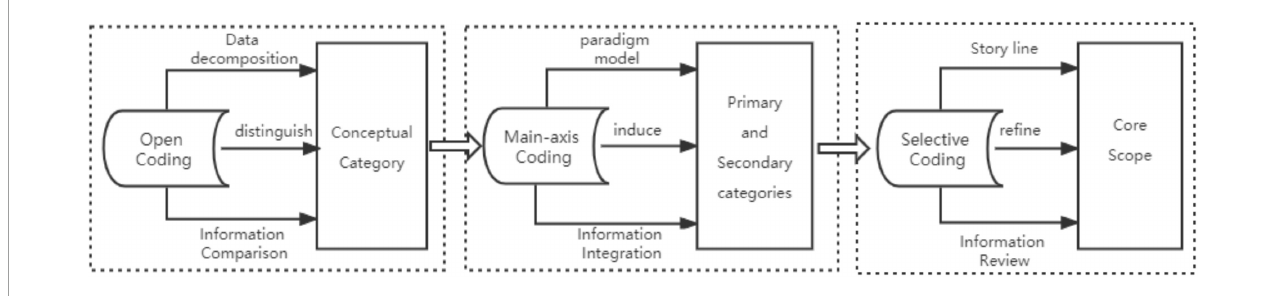
FIGURE2 The framework of grounded theory research thinking.